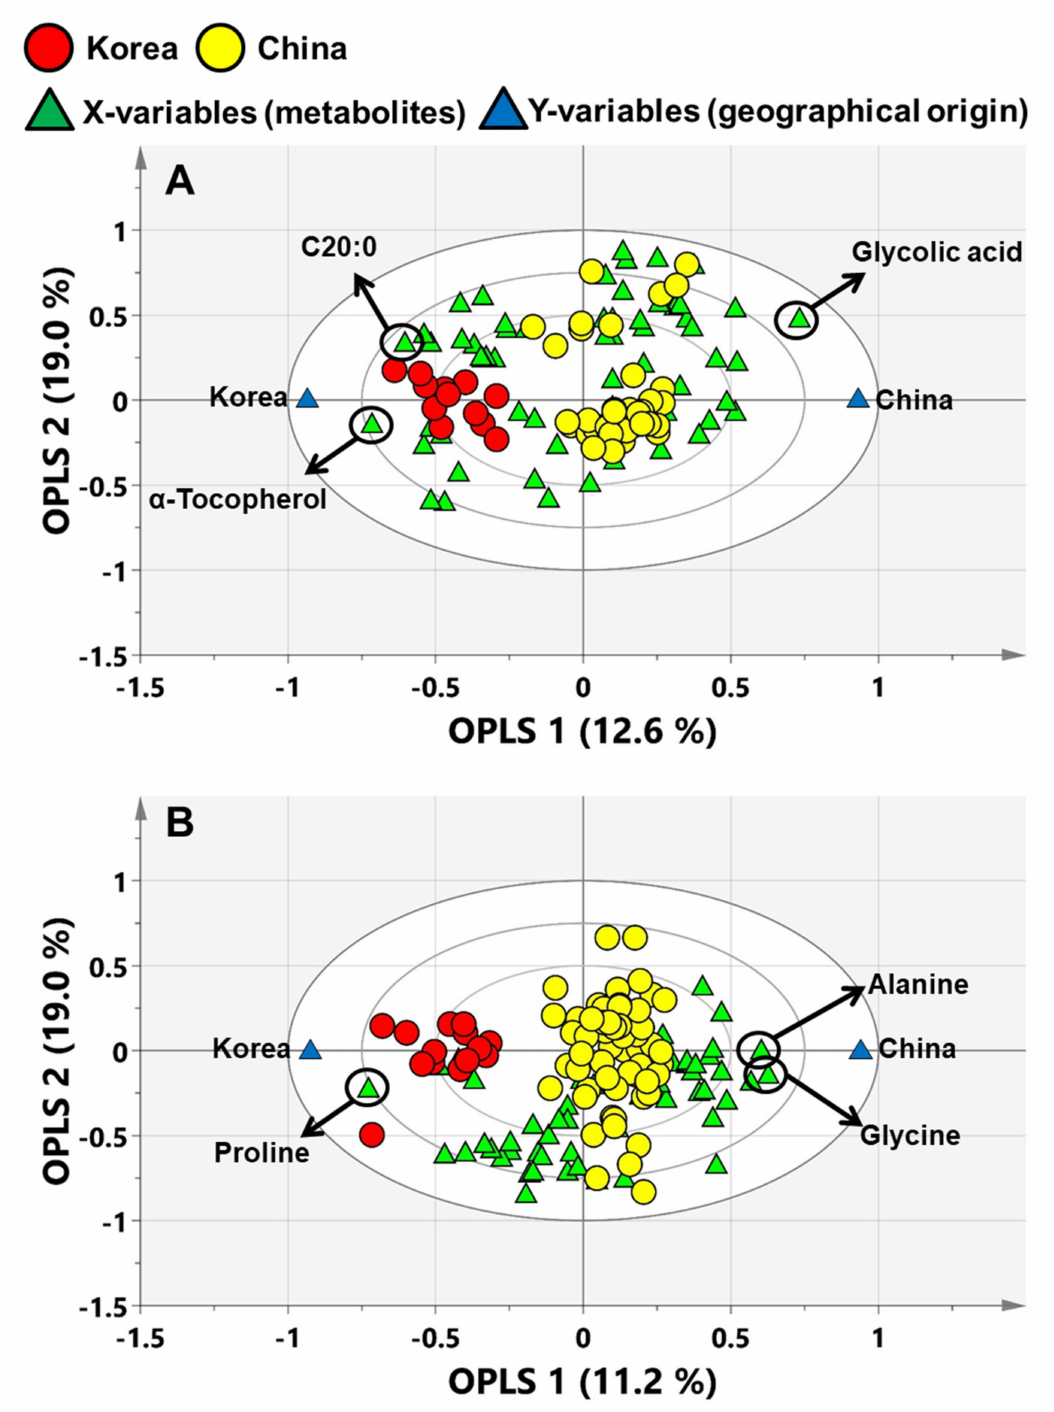
Figure 3. The OPLS-biplot for discriminating the geographic origin of ( A ) perilla and ( B ) sesame seeds using metabolite profiling data. The OPLS-biplot showed correlation of all metabolites (X-variables), sample clusters (observations) and geographic origins (Y-variables). C20:0; arachidic